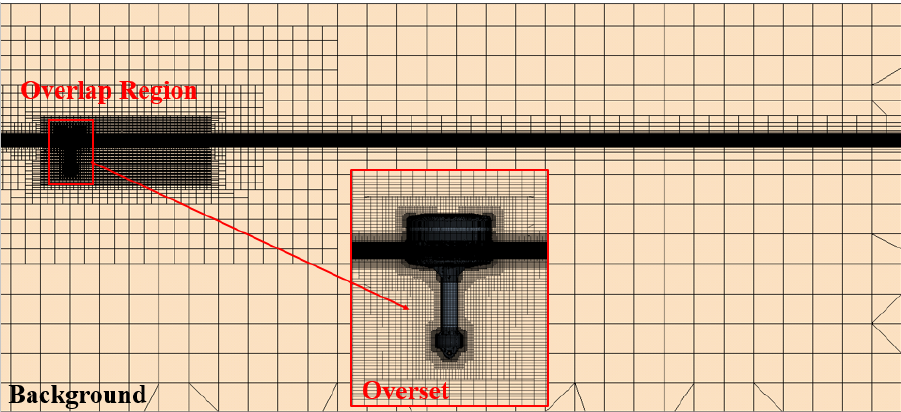
Figure 16. Grid system for motion simulations of lightweight light buoys in regular waves using CFD.